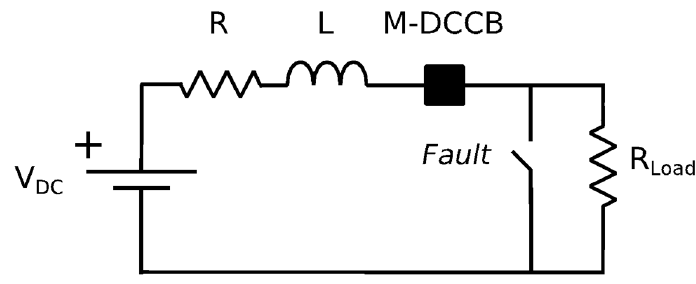
Figure 5. Simplified DC test bed.